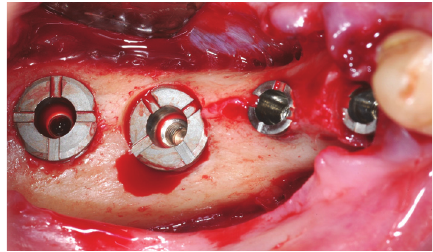
Figure 5: Wide-short implants installed at the bone